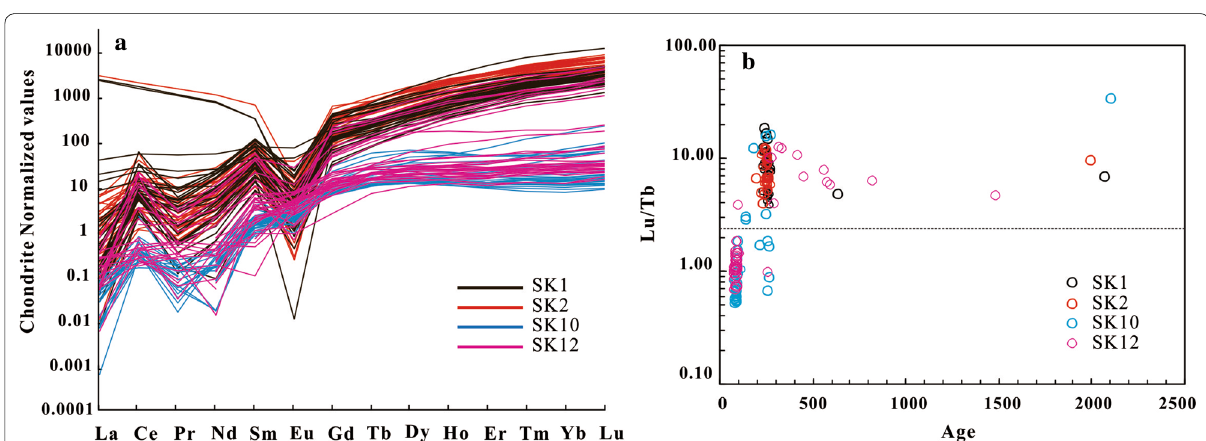
Fig. 9 Chondrite-normalized REE patterns ( a ) and age vs. La/Tb ratio ( b ) of zircon grains from augengneiss, and leucogneiss samples. CI (chondrite Ivuna) values are from Taylor and McLennan